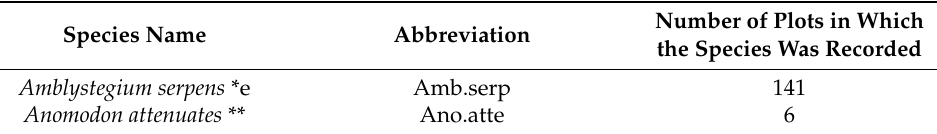
Table A1. List of the bryophyte species recorded with some information of their occurrence and